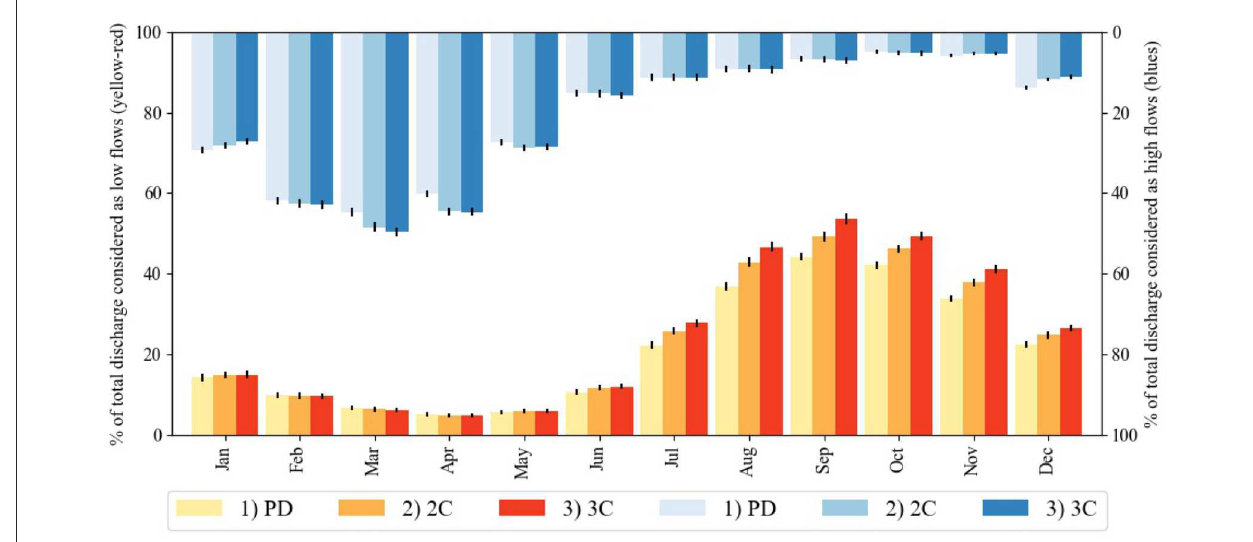
FIGURE3 Seasonal cycle of the percentage of time in a month of low and high flows under different scenarios including present day, 2 ◦ C and 3 ◦ C warmer climate (PD, 2C, and 3C). Low flows are highlighted in yellow (PD), orange (2C) and red (3C), high flows in light blue (PD), blue (2C), and dark blue (3C). Results are averaged over all models for all stations of the study area. Whisker represent 20 th and 90 th percentile of the uncertainty analysis based on bootstrap calculation of the mean.